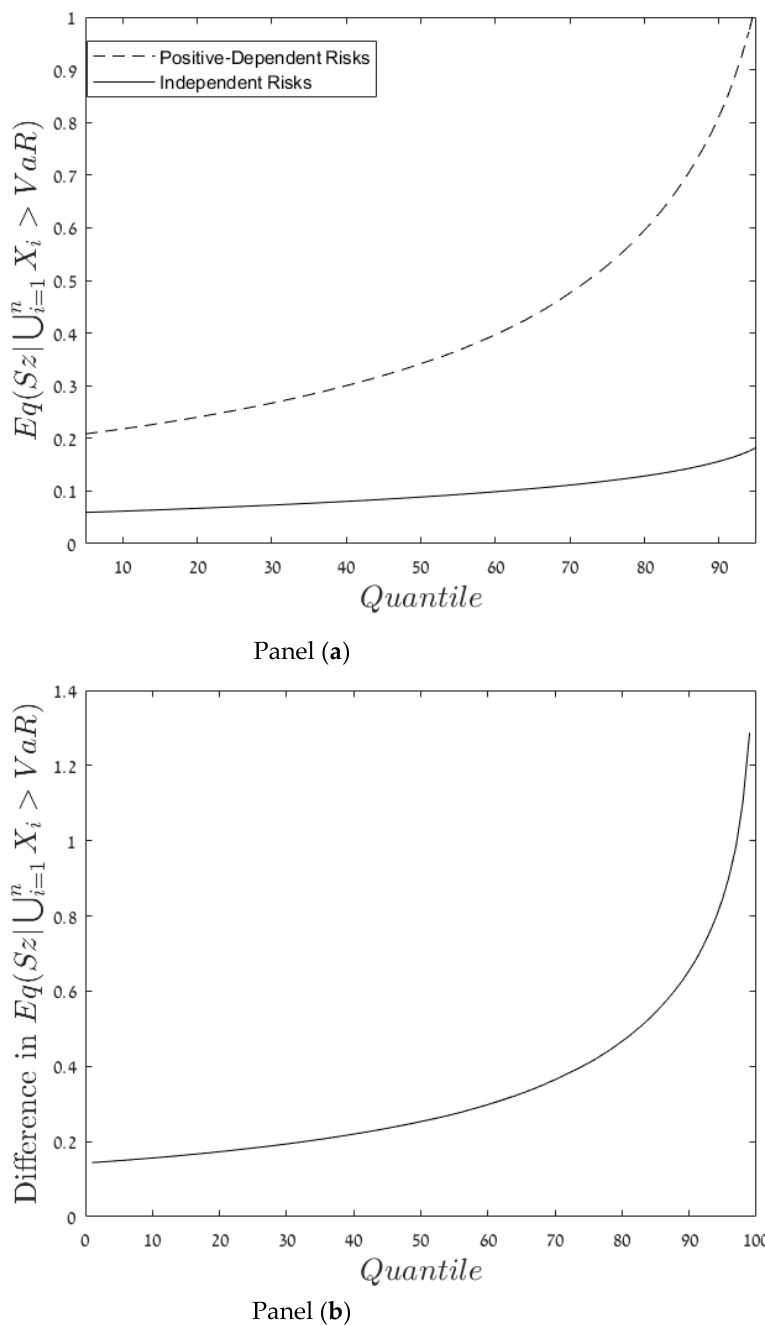
Figure 1. Tail conditional expectation of the reinsurer’s aggregate risks, for different quantile levels. Panel ( a ) shows the conditional tail expectation of the aggregate loss, assuming positive-dependent and independent risks. Panel ( b ) shows the difference in the tail conditional expectation between positive-dependent and independent risks, for various quantile levels.